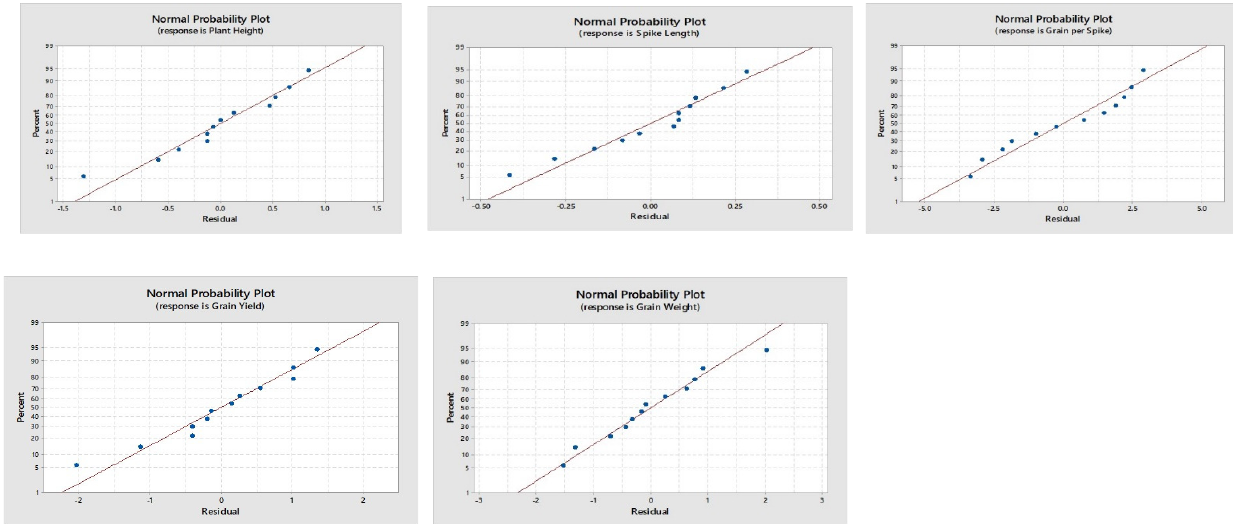
Figure 4. Normal probability plot of the harvesting parameters .